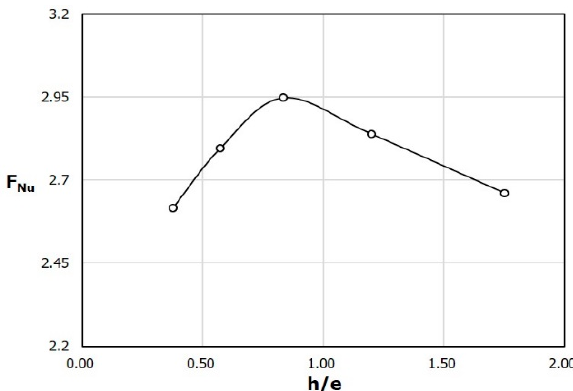
Figure 15. Variation of F Nu with the ratio of the rib height to the rib width (h/e) (rib area = 375 mm 2 ).